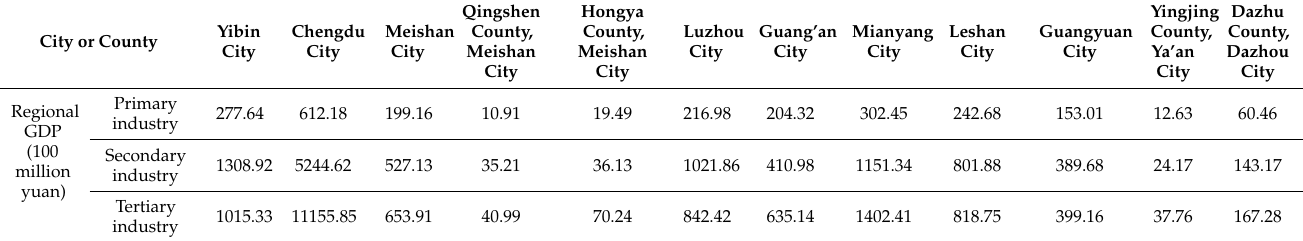
Table 2. Economic situation of the characteristic towns in the research areas of Sichuan